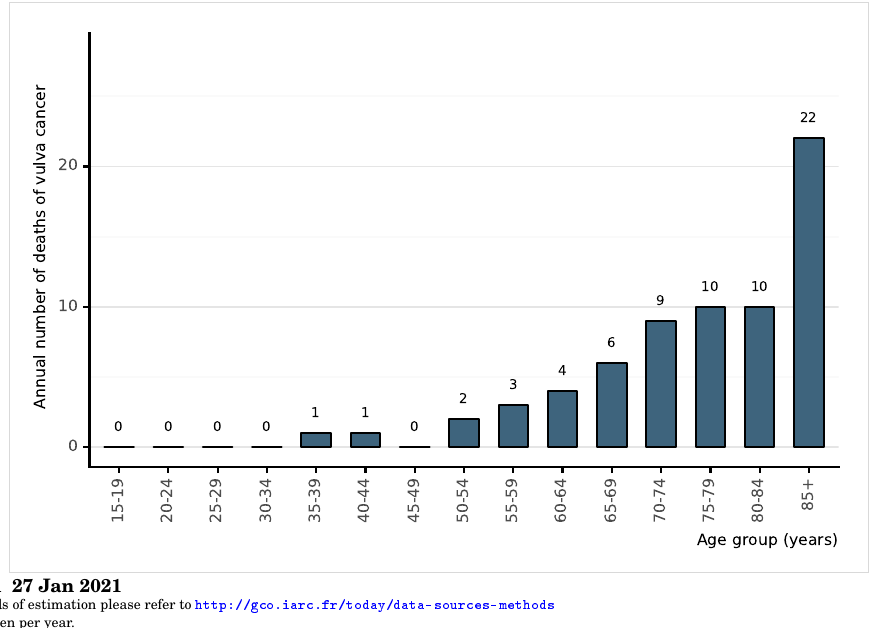
Figure 24: Annual number of deaths of vulva cancer in Peru (estimates for